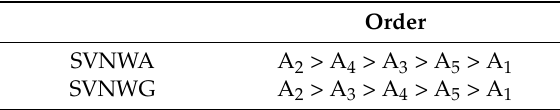
Table 3. Order of the emerging technology